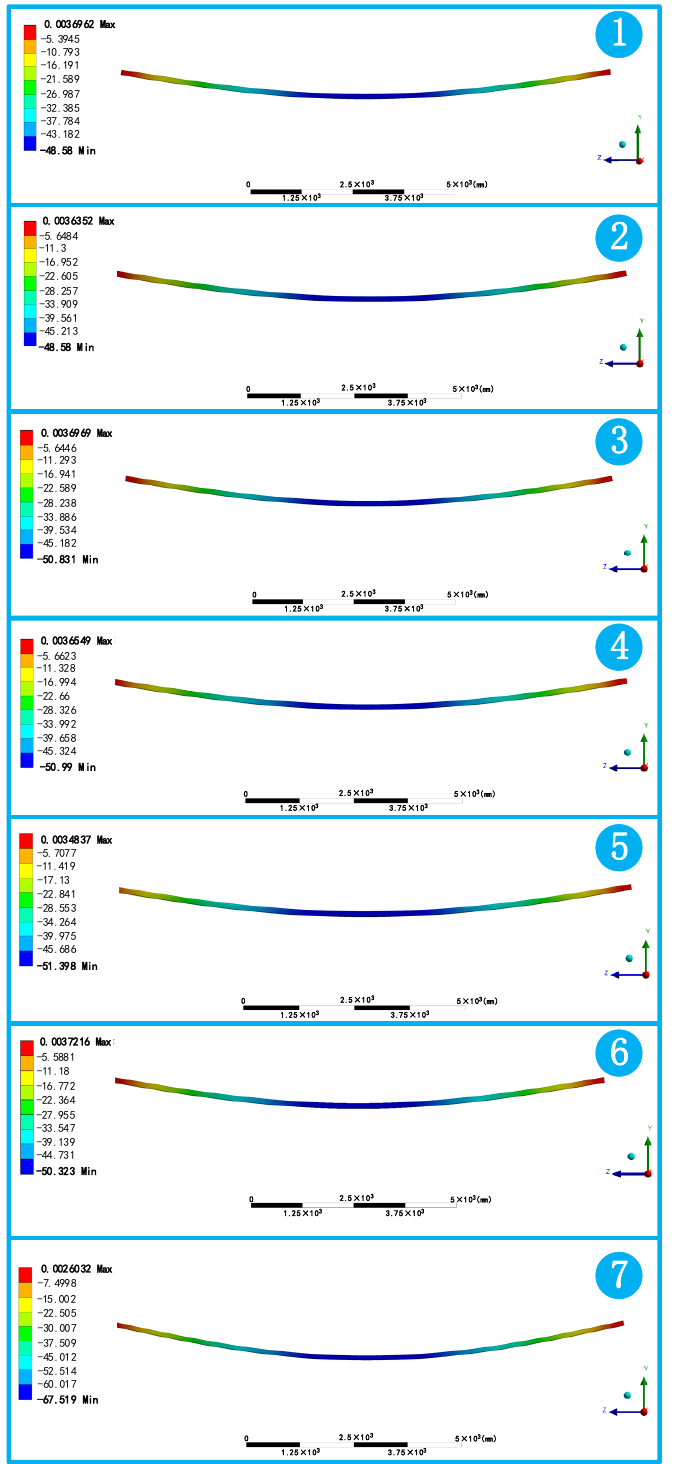
Figure 6. Static deflections of conductor rail with standard specification. No. 1 – 6 denote the results of new types of conductor rail with large moment of inertia, and the result of the conventional one is denoted as No. 7.